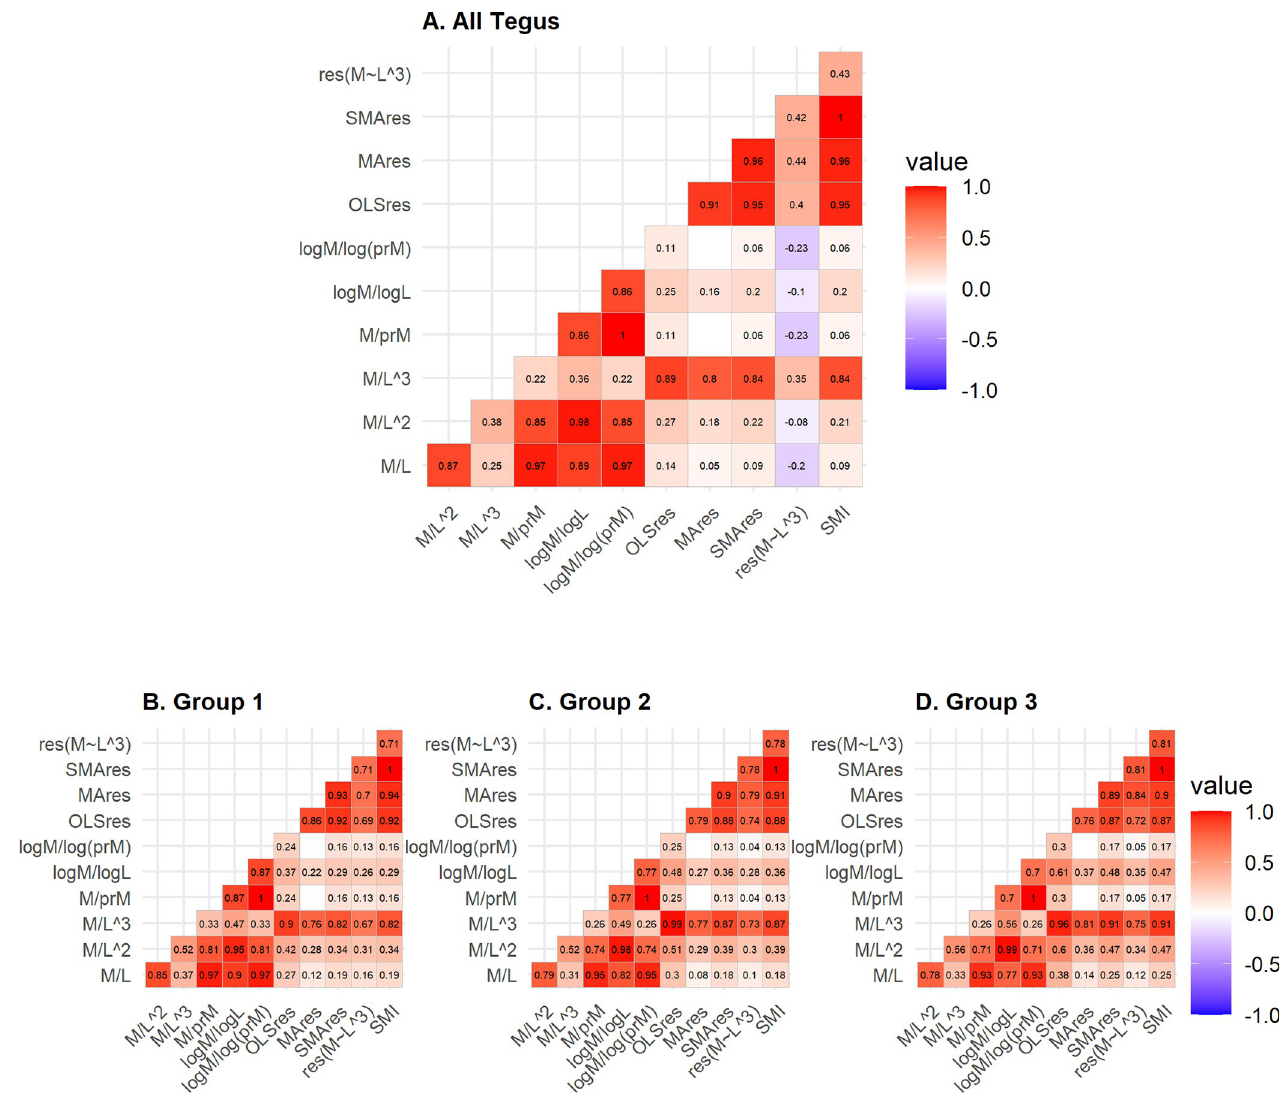
Fig 3. Correlation (Kendall’s τ ) among 11 BCIs used in this study, for all tegu (A) and by size class (B-D). Correlations which were insignificant have no displayed τ